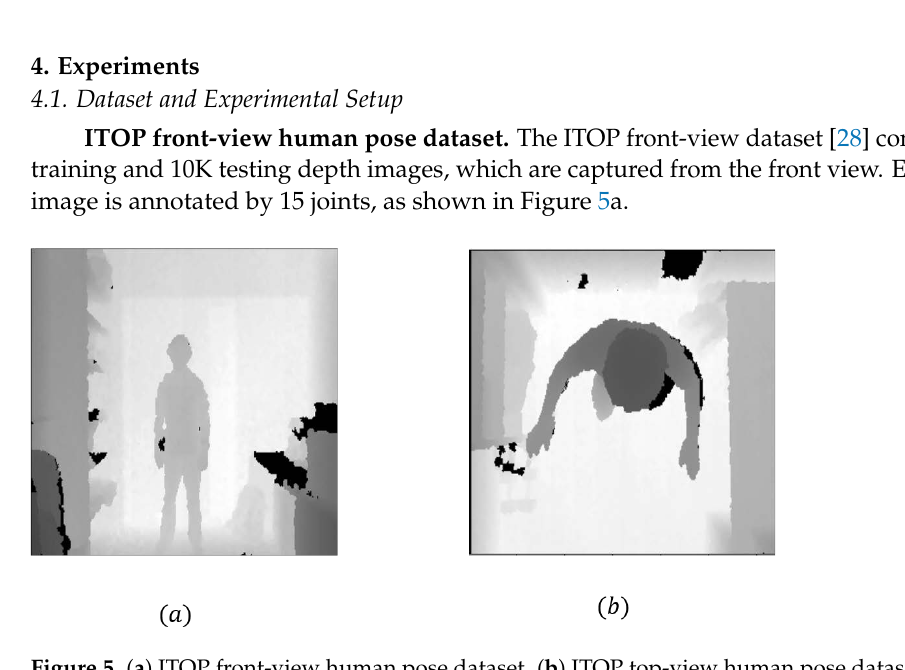
Figure 5. ( a ) ITOP front-view human pose dataset. ( b ) ITOP top-view human pose dataset. ITOP top-view human pose dataset. The ITOP top-view dataset [28] contains 40K training and 10K testing depth images, which are captured from the top view. Each depth image is annotated by 15 joints, as shown in Figure